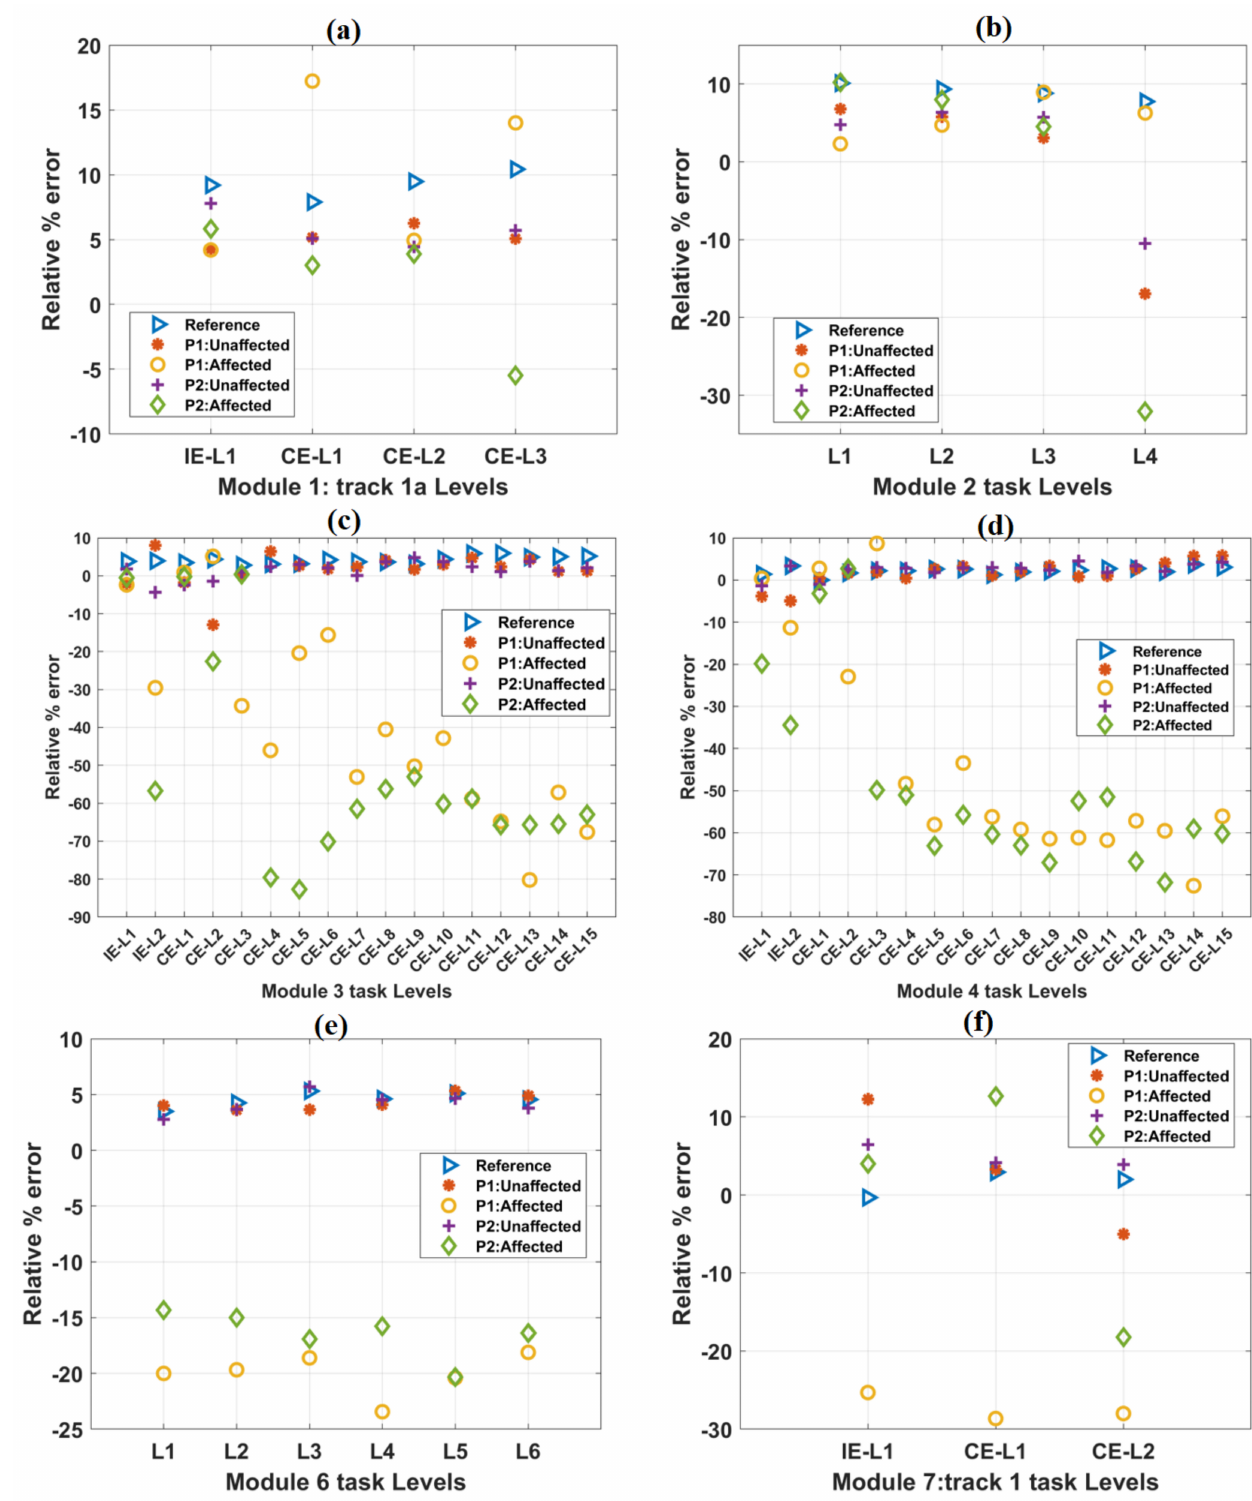
Figure 6. The variation of the relative % error parameter with the increase in difficulty levels in ( a ) Module 1, ( b ) Module 2, ( c ) Module 3, ( d ) Module 4, ( e ) Module 6, and ( f ) Module 7 tasks. In each case, the scores of both the patients were plotted against the mean score of forty healthy subjects, which is taken as a reference. In most of the cases, relative % error values obtained from the affected hands of both the patients were relatively less than these reference